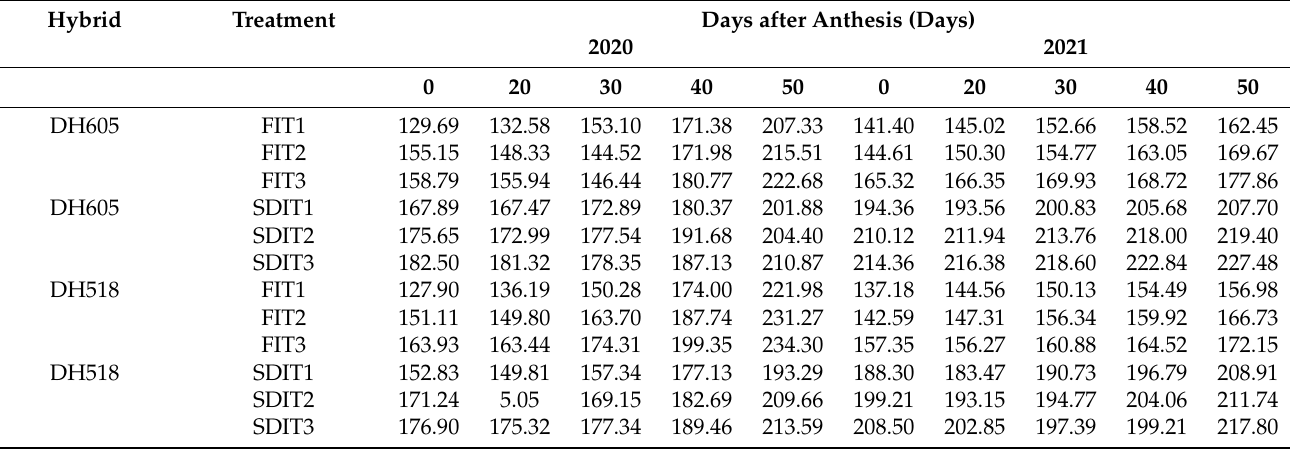
Table 8. Intercellular CO 2 concentration (C i ) of two corn hybrids differing in maturity under different irrigation treatments (CO 2 µ mol/mol).